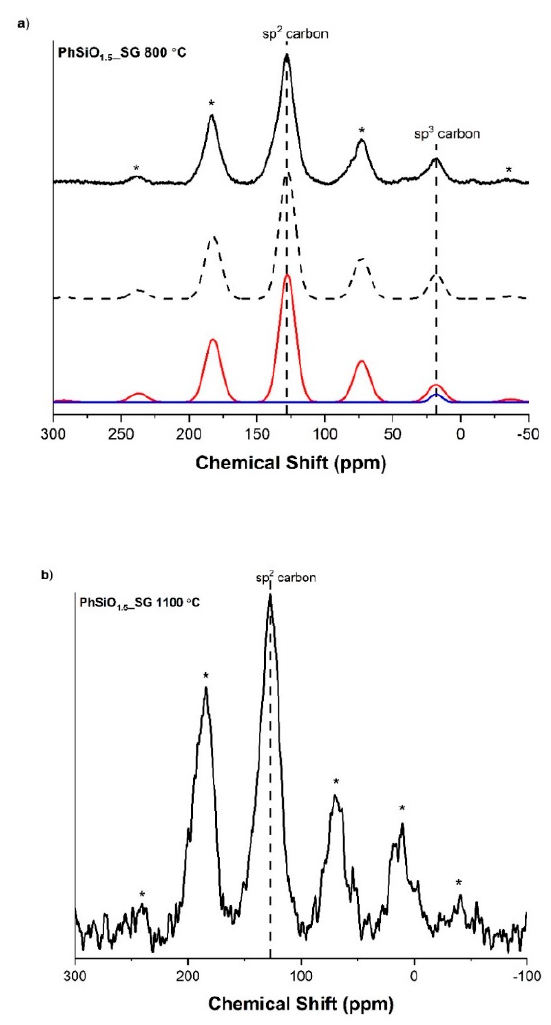
Figure 7. 13 C( 1 H) CPMAS NMR for PhSiO 1.5 _SG samples. ( a ) Sample pyrolyzed to 800 ◦ C with peaks at ~127 ppm and 18 ppm, corresponding to sp 2 hybridized carbon and sp 3 hybridized carbon, respectively. ( b ) Sample pyrolyzed to 1100 ◦ C with an isotropic peak at ~127 ppm, corresponding to sp 2 hybridized carbon. The stars * denote spinning side bands.